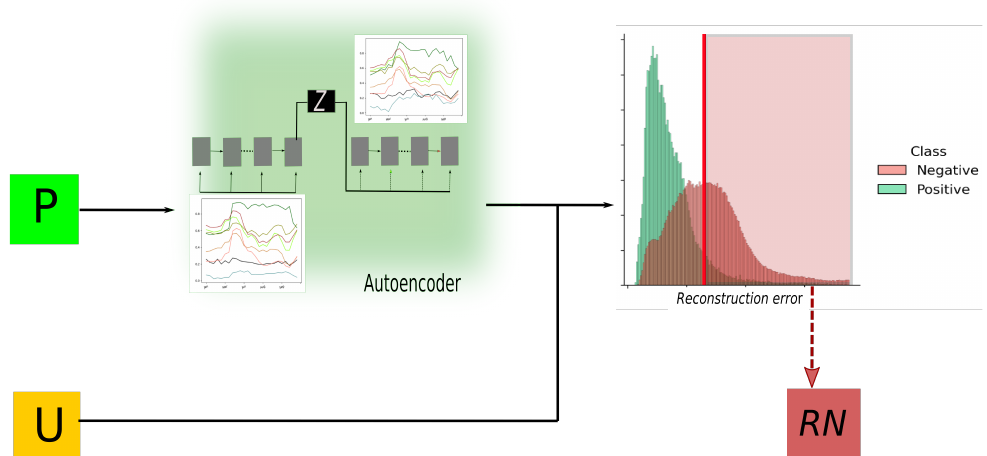
Figure 1. The VAERNN is trained on the set of positively labelled samples P . Then, the model is applied on the set of unlabelled samples U . Successively, the reconstruction error for each TS ∈ U is derived, and the set of reliable negative samples RN is identified based on the reconstruction error. The vertical red line indicates the average reconstruction error ( µ rec ) on the set of unlabelled samples U . Samples with a reconstruction error bigger than µ rec are possible candidates for the reliable negative set RN